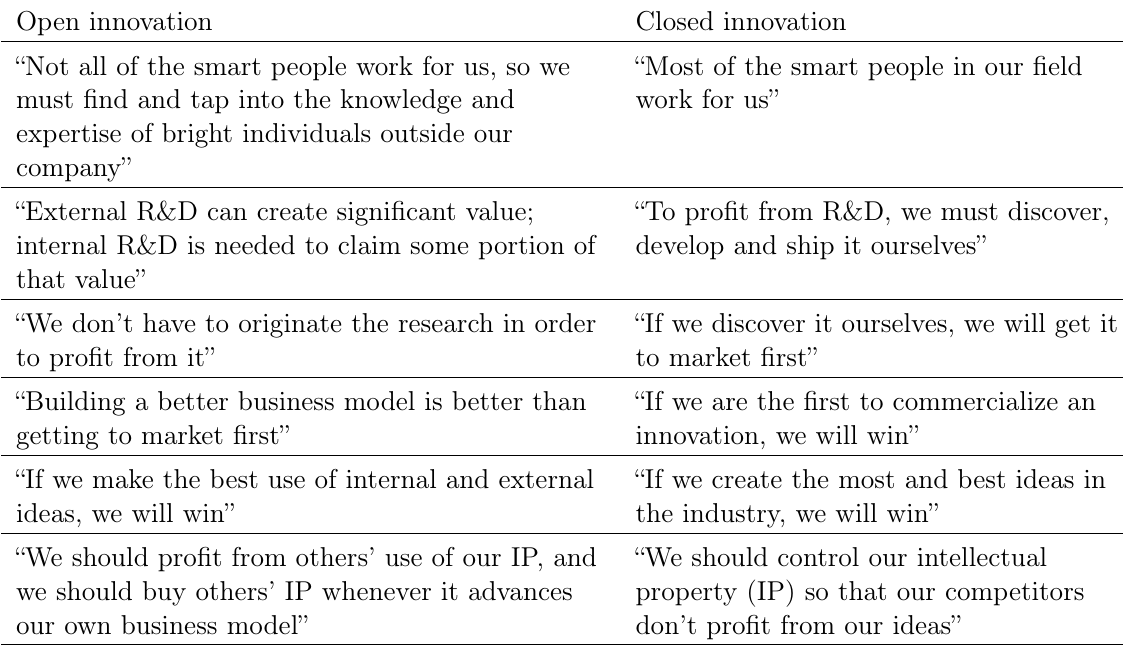
Table A.1. Open innovation versus closed innovation principles Open